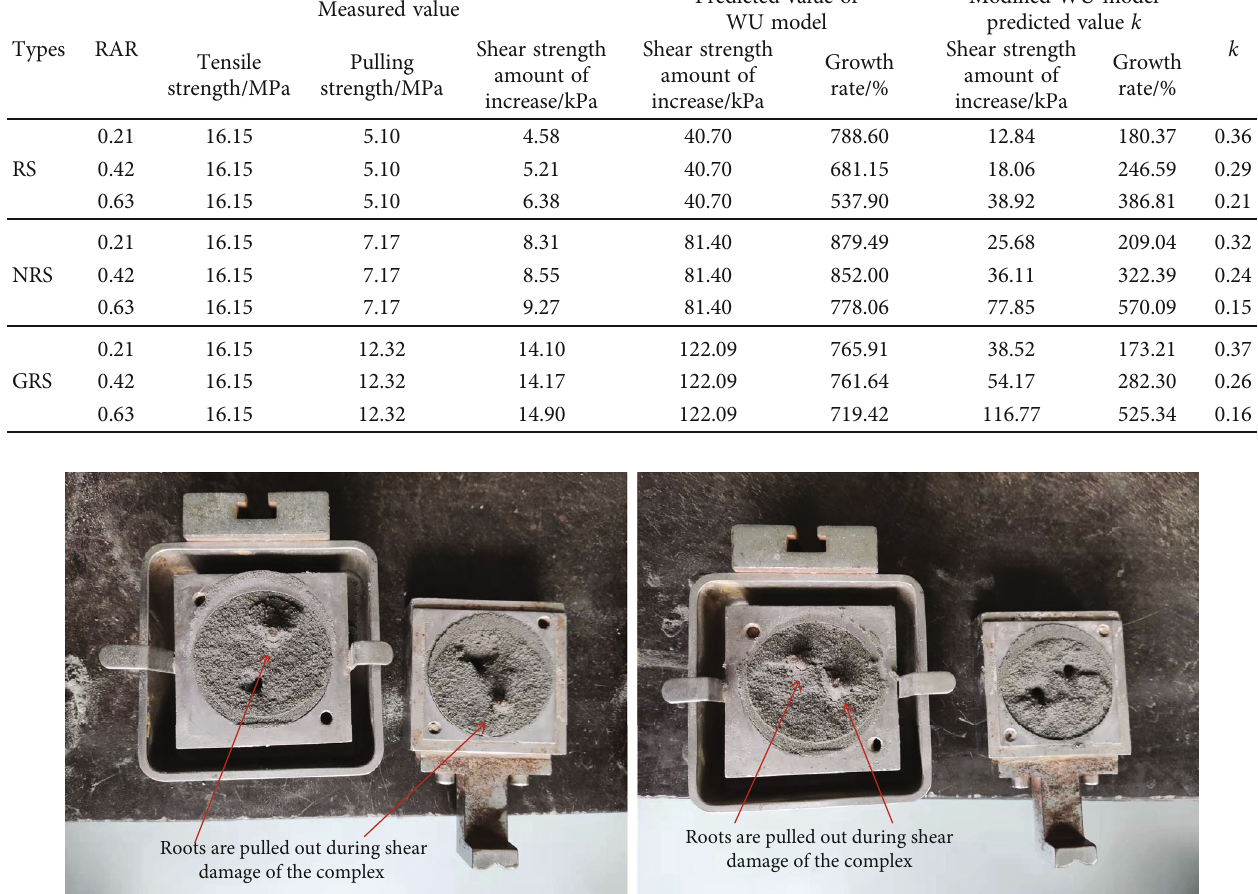
Figure 11: Shear test of A. fruticosa root soil composite tailing